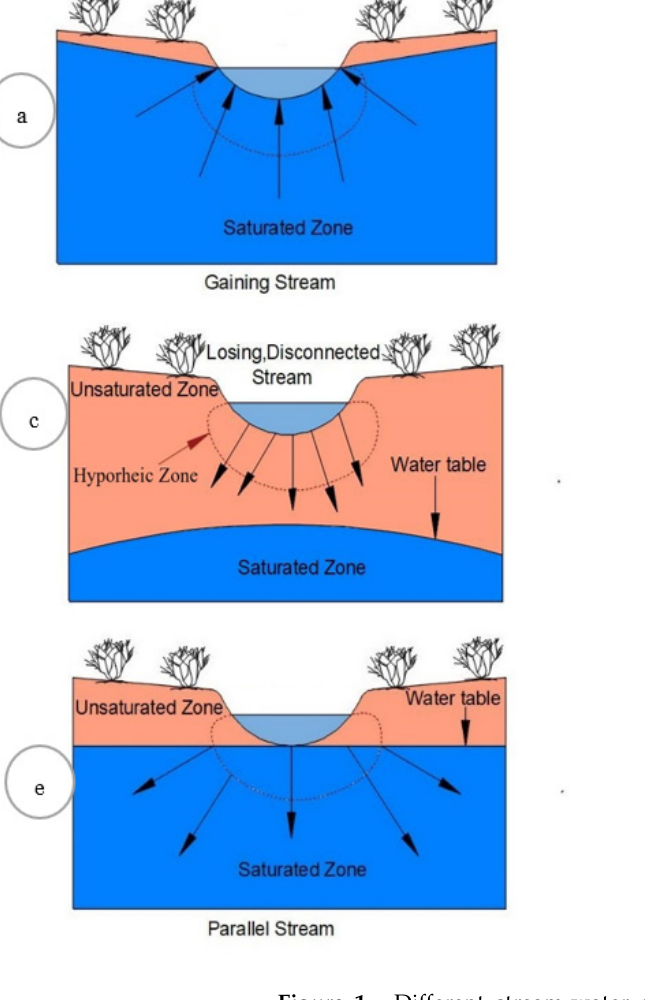
Figure 1. Di ff erent stream-water and groundwater interaction scenarios, ( a ) gaining stream, ( b ) transition-losing stream, ( c ) losing-disconnected stream, ( d ) losing-connected stream, ( e ) parallel stream, ( f ) fl ow-through stream. The arrows denote the directions of fl uid fl ow.